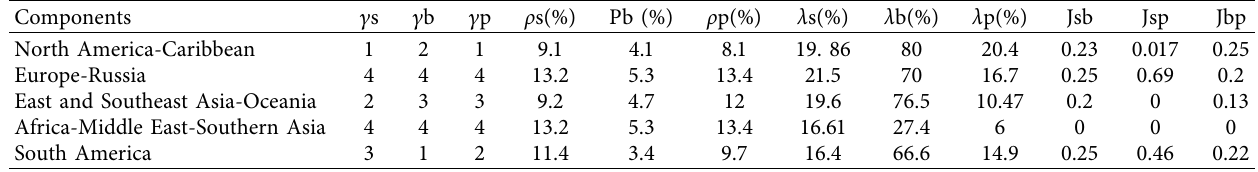
Table 8: Tis table summarizes the results for the attacks under evaluation (strength, weighted betweenness, and weighted PageRank). We report the order of isolation, the proportion of airports removed, and the LCC of the local component. Te Jaccard index between LCCs for attack pairs is reported for each large component. c s, c b, and c p are, respectively, the order of isolation of the LCC from strength, weighted betweenness, and weighted PageRank. ρ s, ρ b, and ρ p are, respectively, the proportion of attacked airports from the world air transportation network according to the strength, weighted betweenness, and weighted PageRank. λ s, λ b, and λ p are, respectively, the LCC from strength, weighted betweenness, and weighted PageRank. Jsb, Jsp, and Jbp represent, respectively, the Jaccard index of the LCCs isolated by strength and weighted betweenness, strength and weighted PageRank, and weighted betweenness and weighted